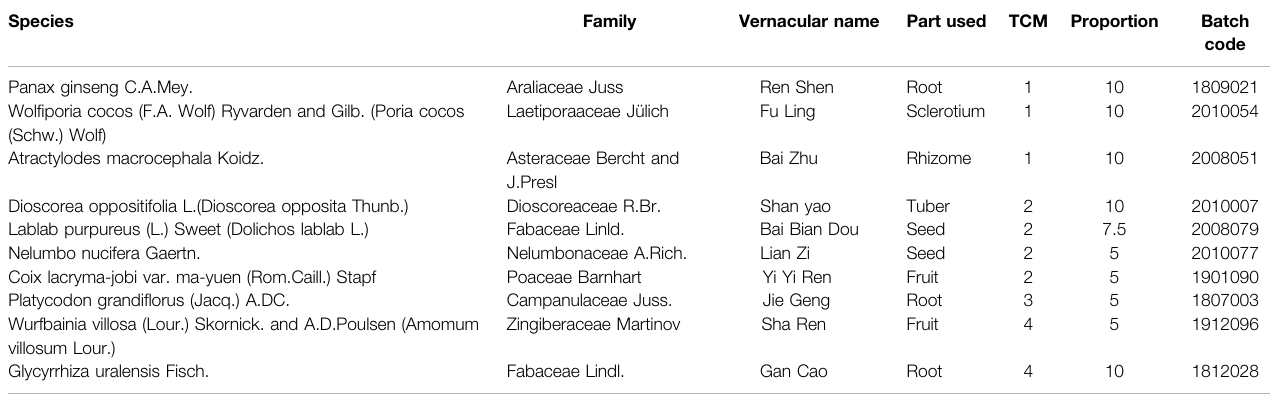
Table 1 Functions of the ingredients in the SBP formula, as attributed in the TCM: 1, are the main ingredients that have the effect of tonifying Qi, invigorating the spleen, and eliminating moisture. 2, can invigorate the spleen, relieve diarrhea, and enhance the ef fi cacy of the active ingredient. 3, circulates Qi. 4, maintain the functions of the spleen and stomach. The nomenclature for plant species in this paper follows the accepted names by IPNI. (2021) and POWO. (2021) and for fungi those accepted by Justo et al. (2017) and Fungorum Species.